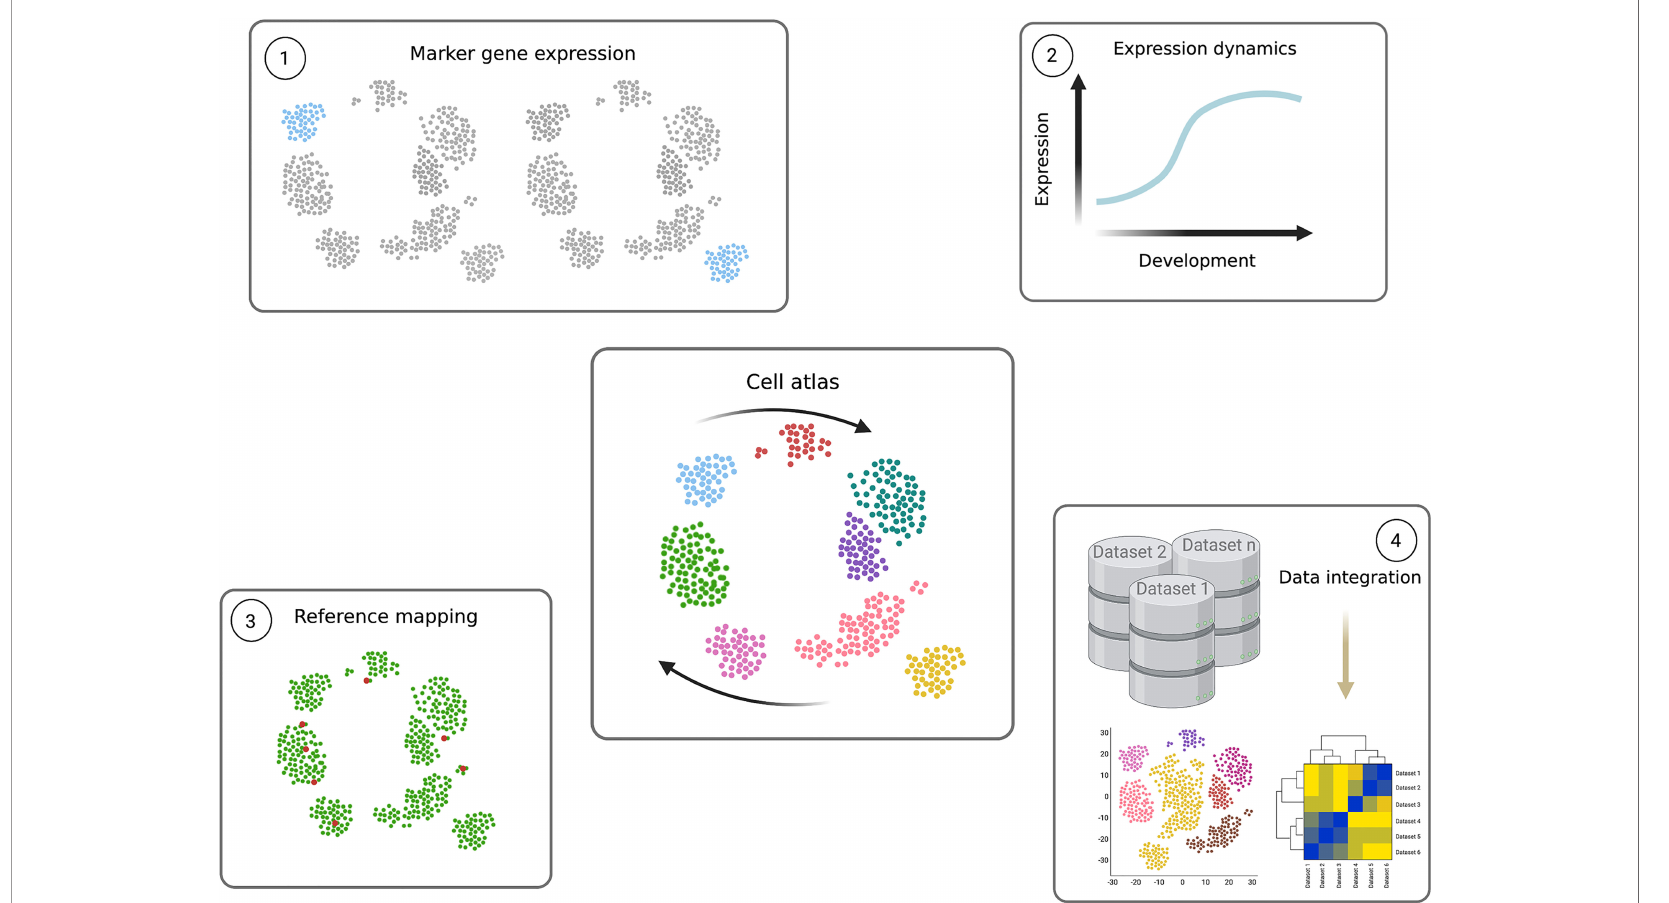
FIGURE 5 | Power of single cell transcriptomics. Cell atlases (central fi gure) contain the transcriptomes of individual cells, organised according to transcript signature similarities and differences in low dimensional space. The result is a transcriptomic map descriptive of the system in question, which in parasitology can re fl ect the parasite ’ s complete life cycle (expressed as arrows). Individual parasite transcriptomes of the same life cycle form (single points) are positioned close together and, if captured, cells undergoing differentiation between different forms are positioned between the cell type clusters. These data can be mined and used as highly valuable resources in several ways. 1) Clustering analyses can be used to group similar cells in increasing resolution, often to identify life cycle forms. Differential expression analysis between clusters reveals novel marker genes, speci fi cally expression in a particular cluster. 2) Pseudotime analysis can be performed to identify dynamic gene expression patterns across the life cycle. A path, or trajectory, is drawn through the cell atlas map connecting neighbouring cells and differential expression analysis is performed as a function of the trajectory. This reveals transcripts which change in level during the life cycle, and the exact expression pattern. Genes which peak in transitioning cells can reveal novel regulators. 3) The cell atlas can further be used as a reference to which query single cell transcriptomes can be mapped. For example, when only a few transcriptomes are available, or only those containing fewer transcripts per cell, mapping them to a high quality reference can identify their detailed position in the life cycle. 4) Transcriptomes of different genetically perturbed parasites, varied strains and even different species can also be mapped to the reference cell atlas through data integration methods. This allows detailed comparisons between datasets and across several cell types. Figure created with